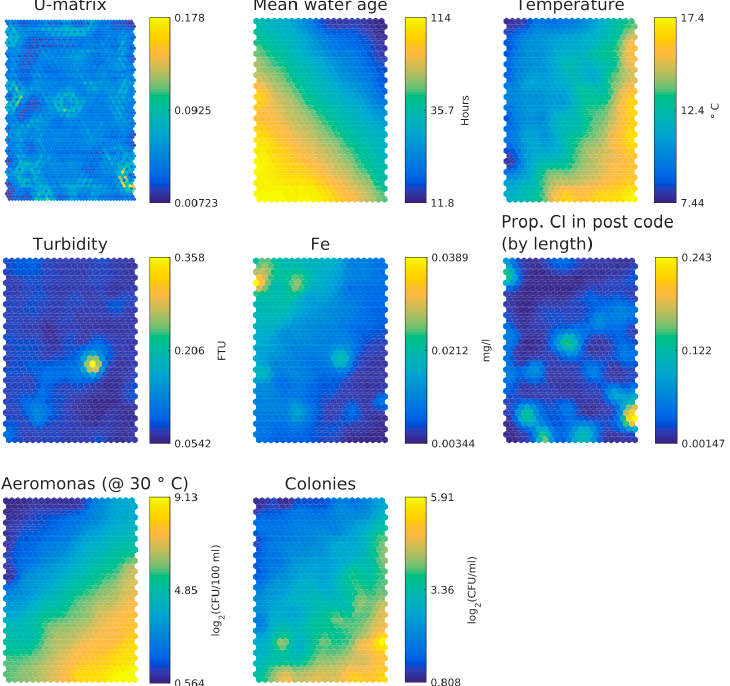
Figure 6. SOM component planes for the Dutch dataset.